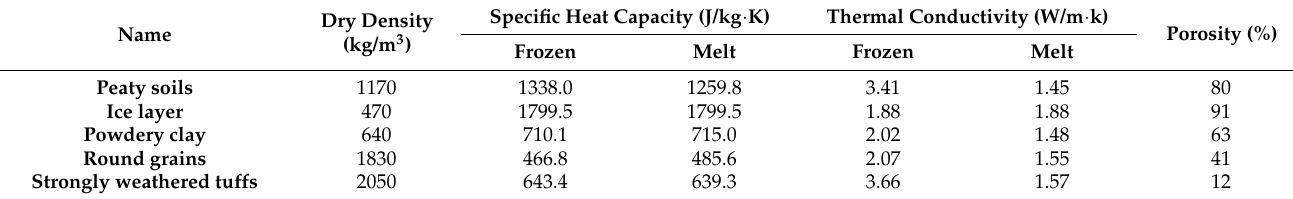
Table 1. Permafrost thermal property parameters.